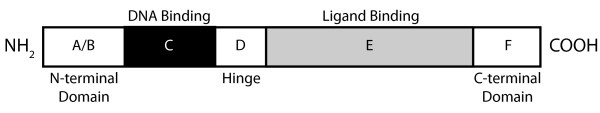
Nuclear receptor gene structure. Nuclear receptors are composed of two well-conserved regions, the DNA binding domain (DBD) and the ligand binding domain (LBD).